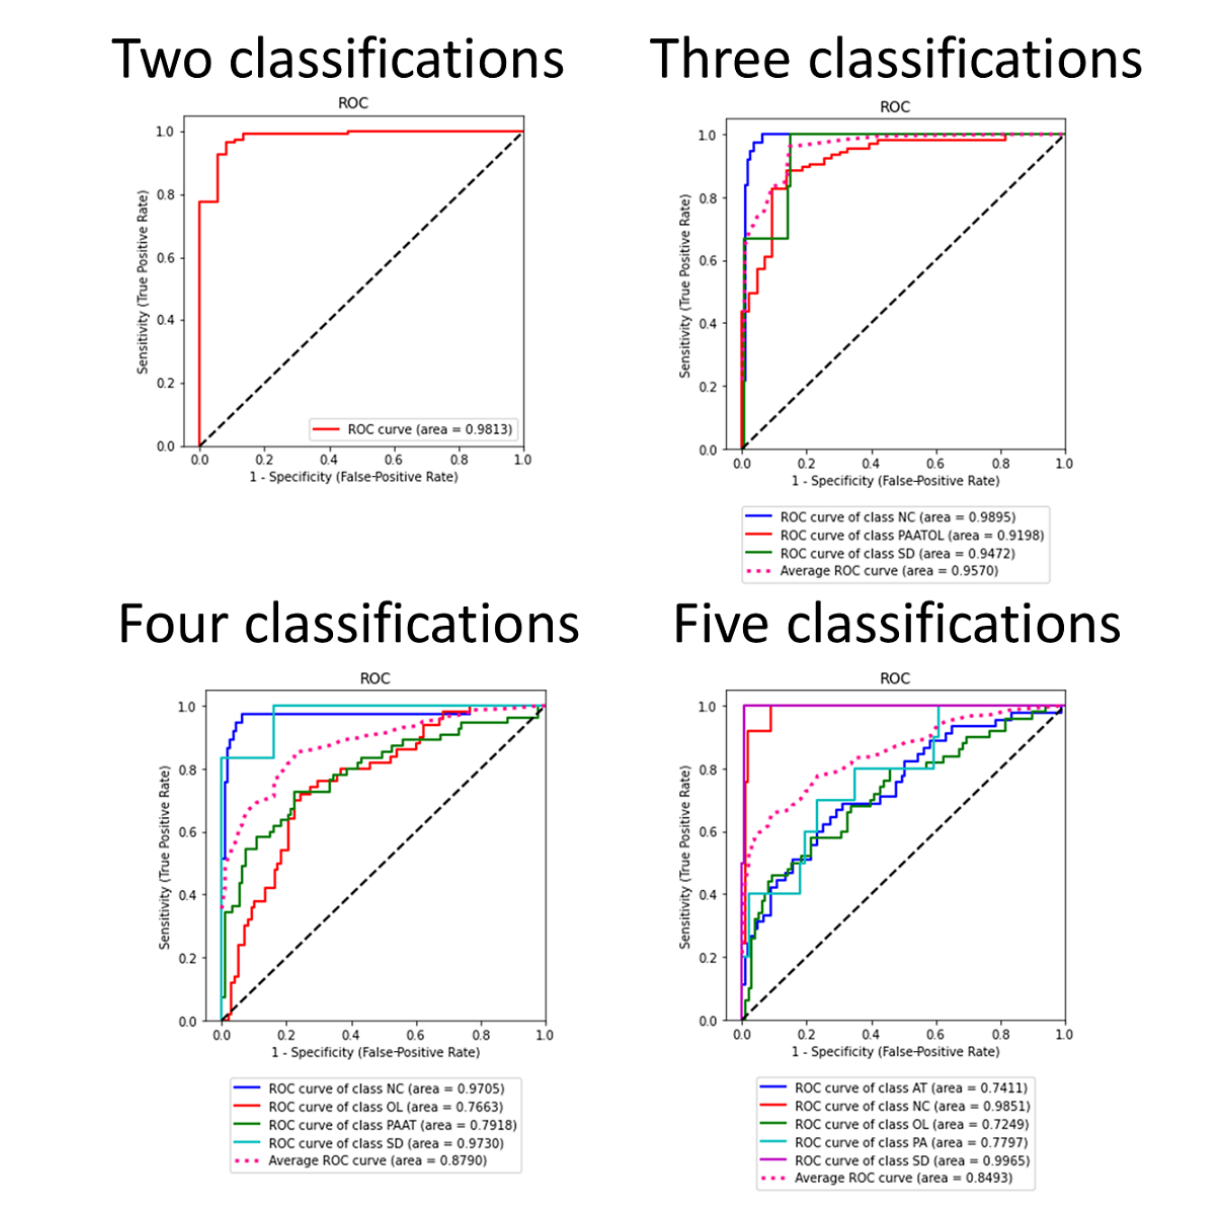
Figure 3. Receiver operating characteristic curves of 2, 3, 4, and 5 classifications. NC = normal voice; SD = adductor spasmodic dysphonia; PAATOL = unilateral vocal paralysis/vocal atrophy/organic vocal fold lesions; OL = organic vocal fold lesions; PAAT = unilateral vocal paralysis/vocal atrophy; PA = unilateral vocal paralysis; AT = vocal atrophy.